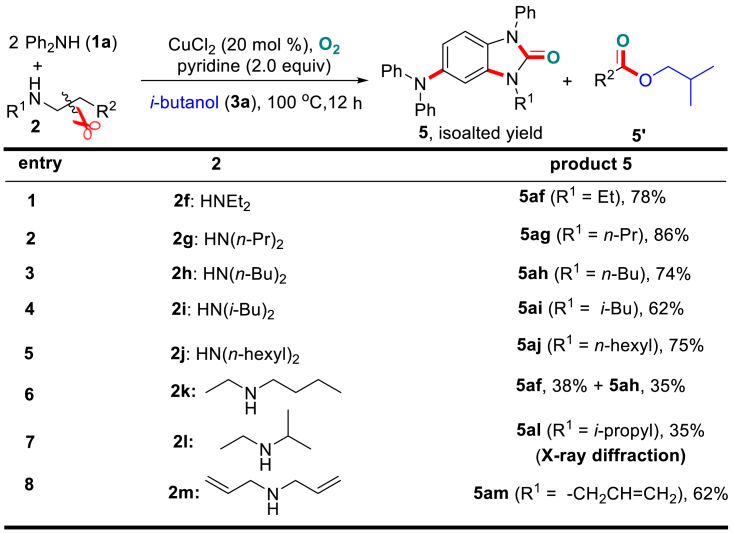
Variation of Open-Chain DialkylaminesStandard condition deviation: without addition of Na2CO3. Also see Figures S38–S51 and S88 and Tables S2–S6.